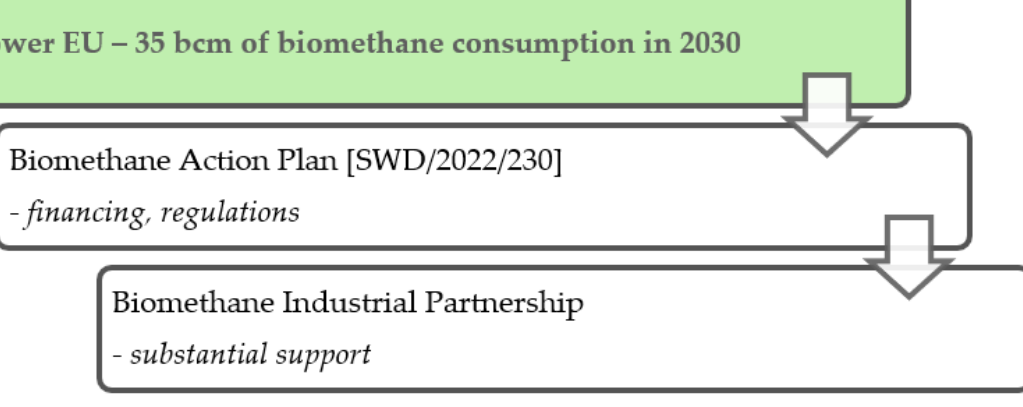
Figure 3. Scheme of REPower EU’s biomethane target realization. Source: own elaboration.